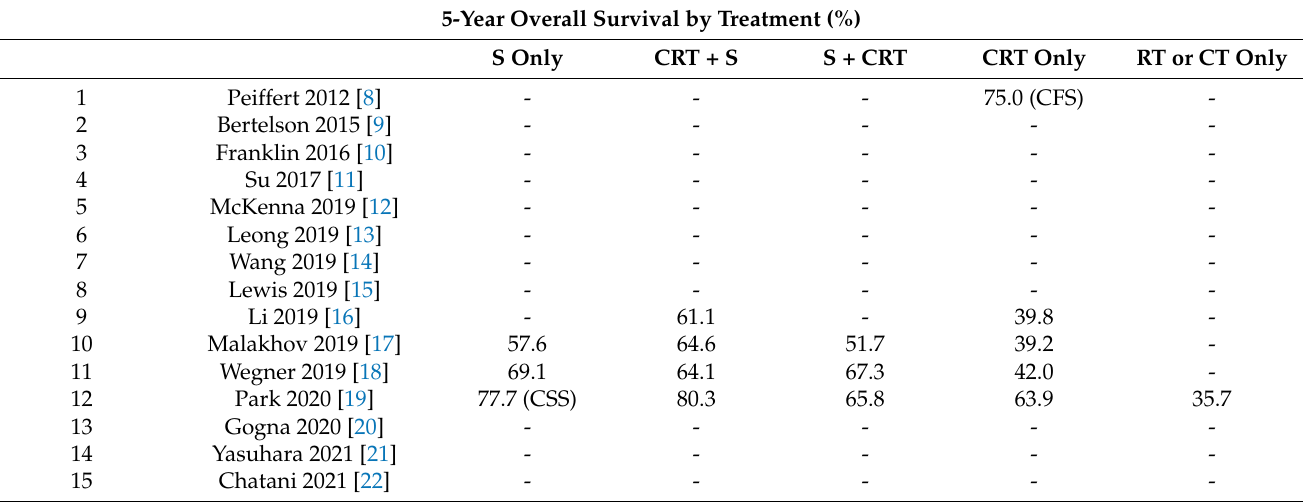
Table 1. Overall survival rates by treatment at 5 years (primary outcome